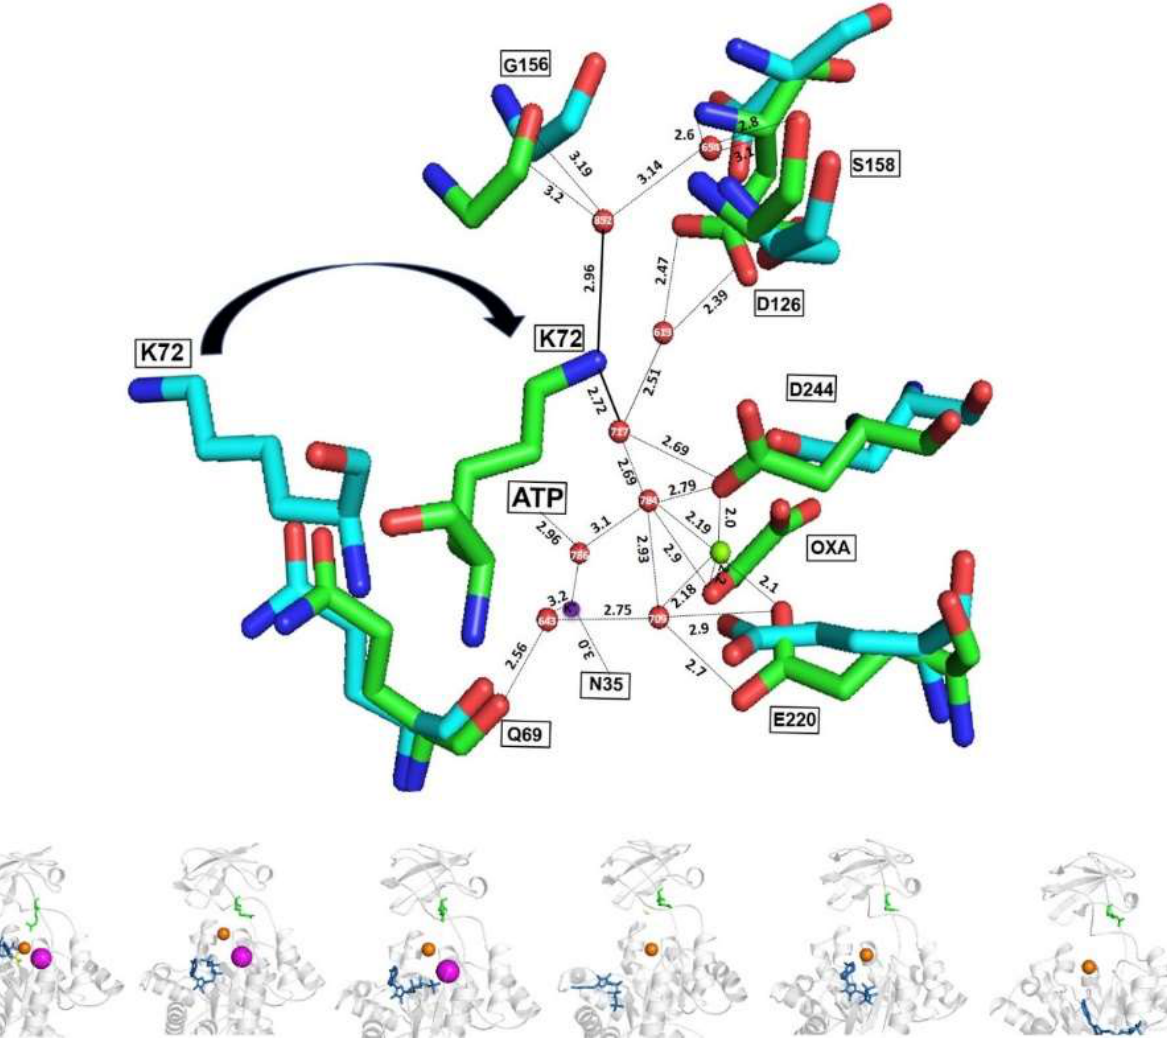
Figure 11. Ribbon representation of the active sites of Mtb PK in the holo (green) and the apoenzyme (cyan); and MD. Superposition of the coordinates of the holo- (PDB 5WS9 subunit A; green) to the apoenzyme (PDB 5WRP subunit A; cyan) are shown. As observed in Figure 9, K72 flips out or into the active site in the apo- and holoenzyme, respectively. ε-amino group of K72 interacts with Mg 2+ , Oxalate, Mg-ATP, K + , residues of A domain and of the lid (B domain) via a water network. Num- bering is according to Mtb PK. The bottom part shows the structural models of the MD of Mtb PK every 20 ns, observing the same displacement of the K72 (green sticks). Ligands are represented as follows: ATP (blue sticks) Oxalate (yellow sticks), Mg 2+ (orange spheres) and K + (magenta spheres).